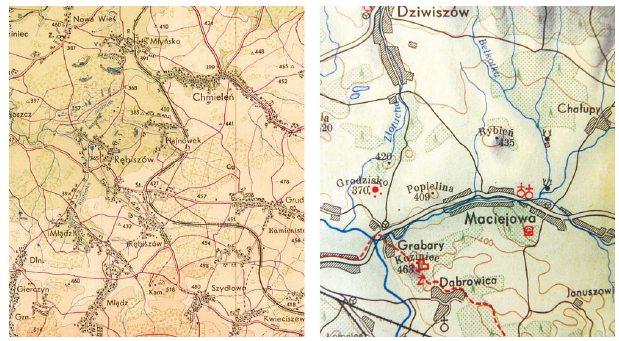
Fig. 3. Comparison of the informative content of maps published in 1947 and